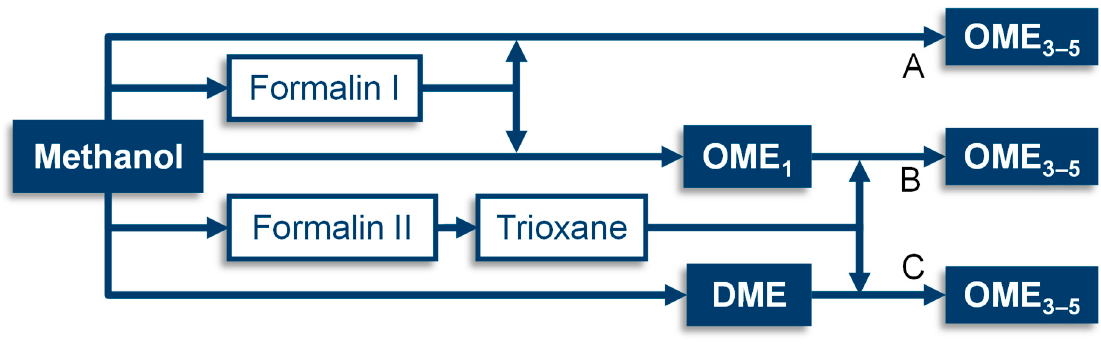
Figure 9. Poly oxymethylene dimethyl ethers with a chain length of 3 to 5 (OME 3–5 ) synthesis routes based on methanol (reproduced with modifications; Burger [21]).